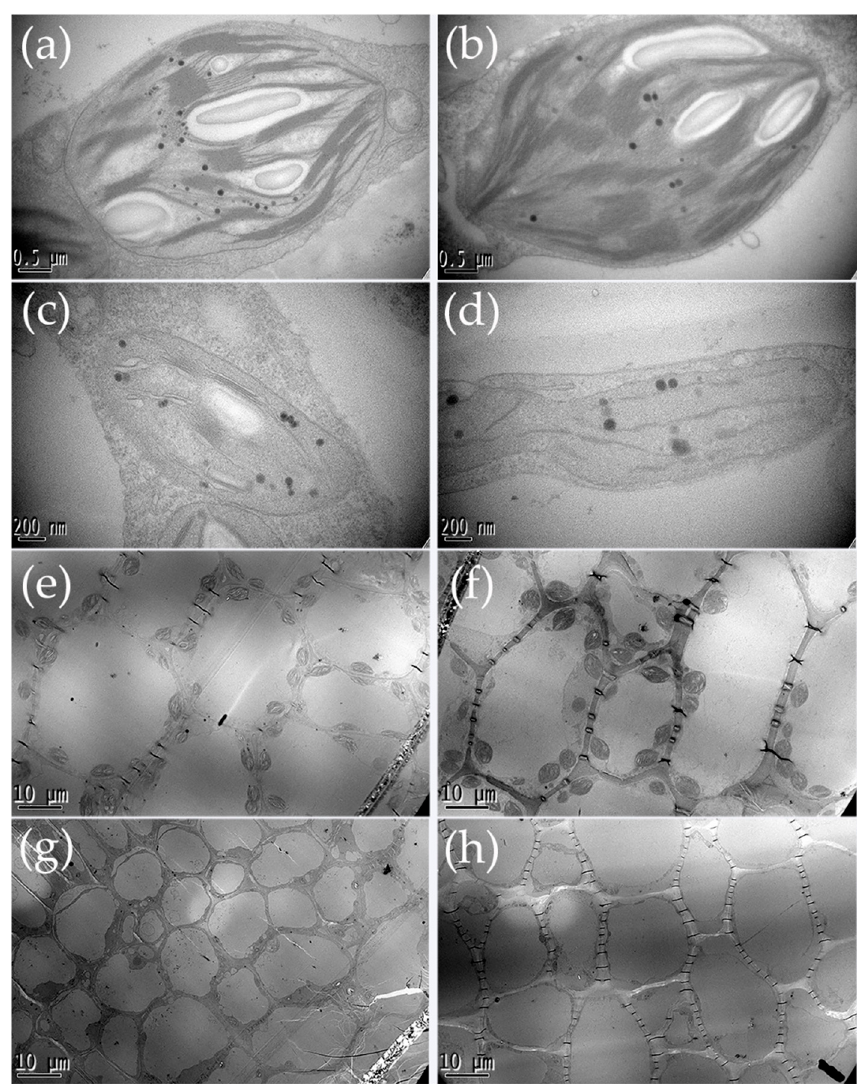
Figure 3. Epidermis chloroplast analysis of Q1 and H4 under microscopy: ( a ) epidermis chloroplast ultrastructure of Q1 in 8-day-old after pollination; ( b ) epidermis chloroplast ultrastructure of Q1 in 13-day-old after pollination; ( c ) epidermis chloroplast ultrastructure of H4 in 8-day-old after pollination; ( d ) epidermis chloroplast ultrastructure of H4 in 13-day-old after pollination; ( e ) epidermis chloroplast number and size of Q1 in 8-day-old after pollination; ( f ) epidermis chloroplast number and size of Q1 in 13-day-old after pollination; ( g ) epidermis chloroplast number and size of H4 in 8-day-old after pollination; ( h ) epidermis chloroplast number and size of H4 in 13-day-old after pollination.